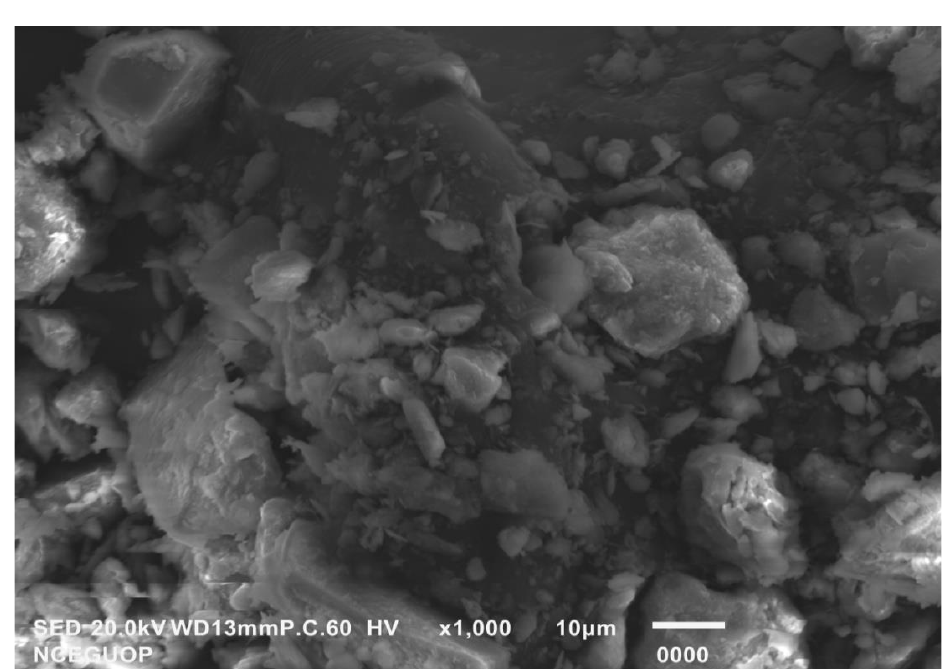
Figure 2. SEM image of anthill catalyst .